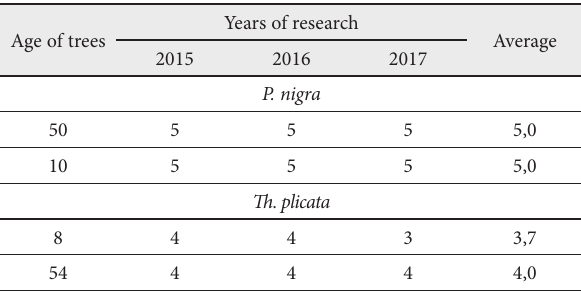
Drought tolerance of P. nigra and Th. plicata of different age periods (in points) Age of